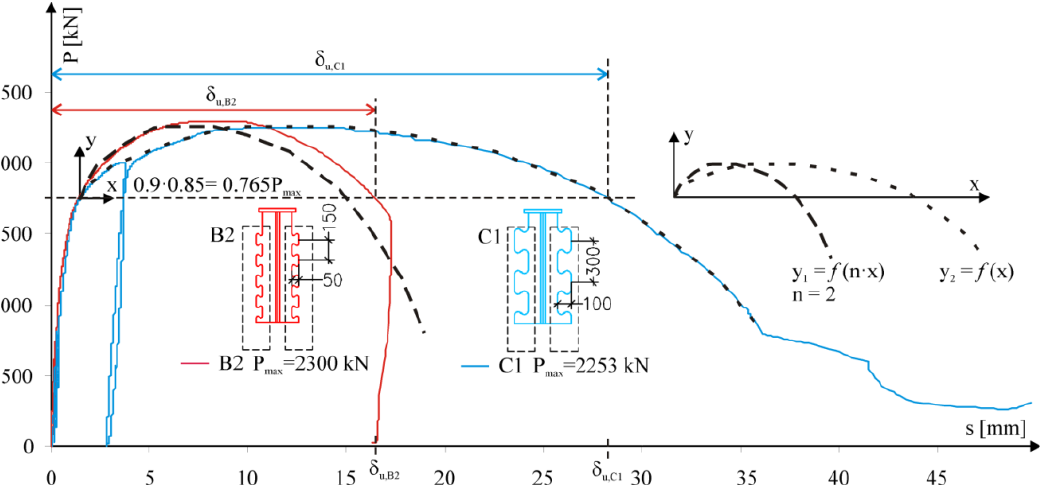
Figure 27: Results of tests for different sizes of dowel [5] (later